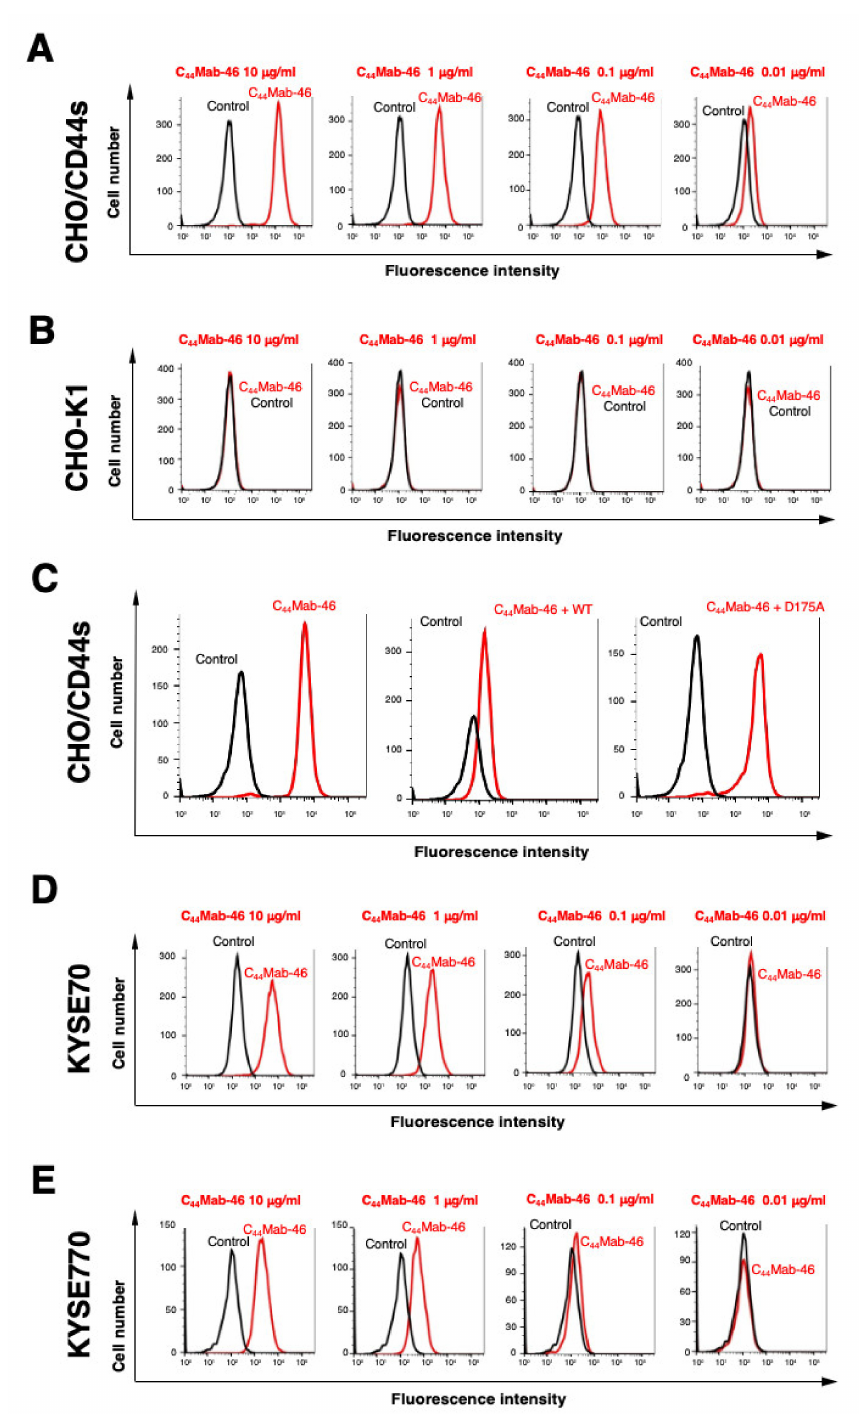
Figure 2. Flow cytometry to CD44 expressing cells using C 44 Mab − 46. ( A , B ) CHO/CD44s ( A ) and CHO − K1 ( B ) cells were treated with 0.01–10 µ g/mL of C 44 Mab − 46, followed by treatment with Alexa Fluor 488 − conjugated anti − mouse IgG. ( C ) C 44 Mab − 46 (1 µ g/mL), C 44 Mab − 46 (1 µ g/mL) plus human CD44 peptide (161 − 180 amino acids, WT) or alanine − substituted peptide (D175A) (10 µ g/mL), and control (blocking buffer) were reacted with CHO/CD44 cells for 30 min at 4 ◦ C, followed by treatment with Alexa Fluor 488 − conjugated anti − mouse IgG. ( D , E ) KYSE70 ( D ) and KYSE770 ( E ) cells were treated with 0.01–10 µ g/mL of C 44 Mab − 46, followed by treatment with Alexa Fluor 488 − conjugated anti − mouse IgG. The black line represents the negative control (block- ing